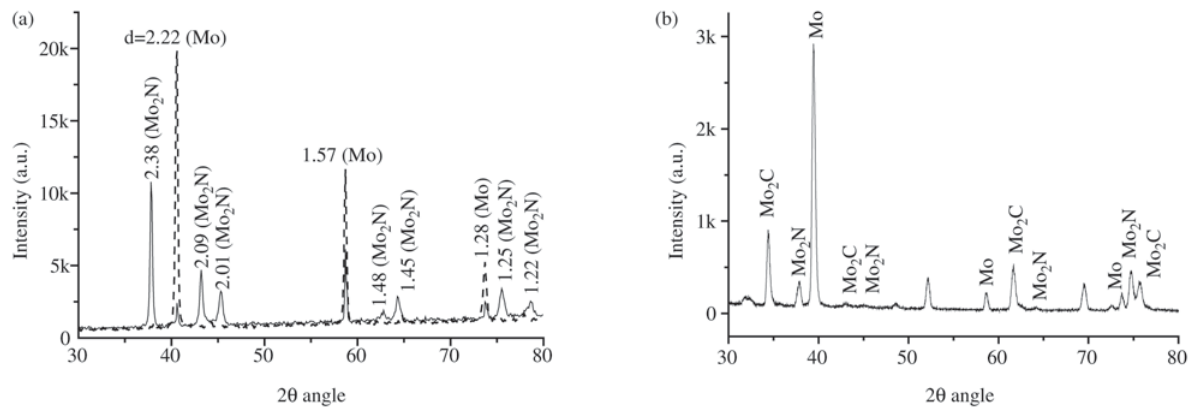
Figure 2. Small angle X-ray Diffraction for: a) pure molybdenum (continuous line) and nitrated molybdenum (dashed line); b) nitrated molybdenum surface after 10 min diamond onset nucleation.